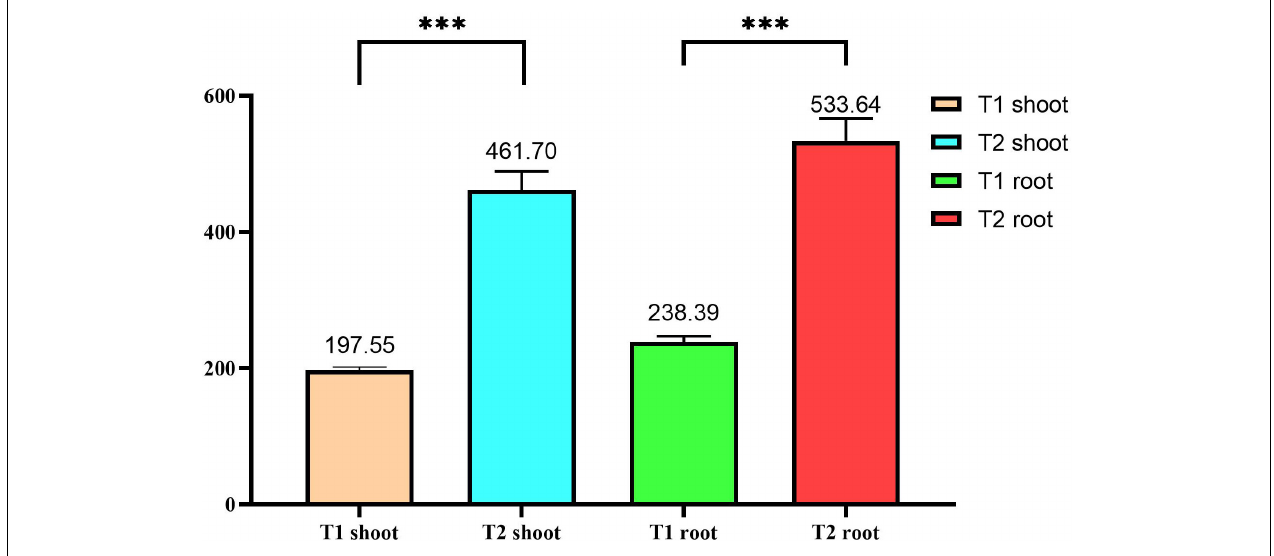
FIGURE 2 | The shoot and root dry weights of Pennisetum giganteum grown in tailing sands for 360 days. The error bars indicate standard deviation ( n = 3). ∗∗∗ Statistically significant difference ( p < 0.05). T1, iron tailing sand + soil + Pennisetum giganteum ; T2, iron tailing sand + soil + bio-matrix pot + Pennisetum giganteum